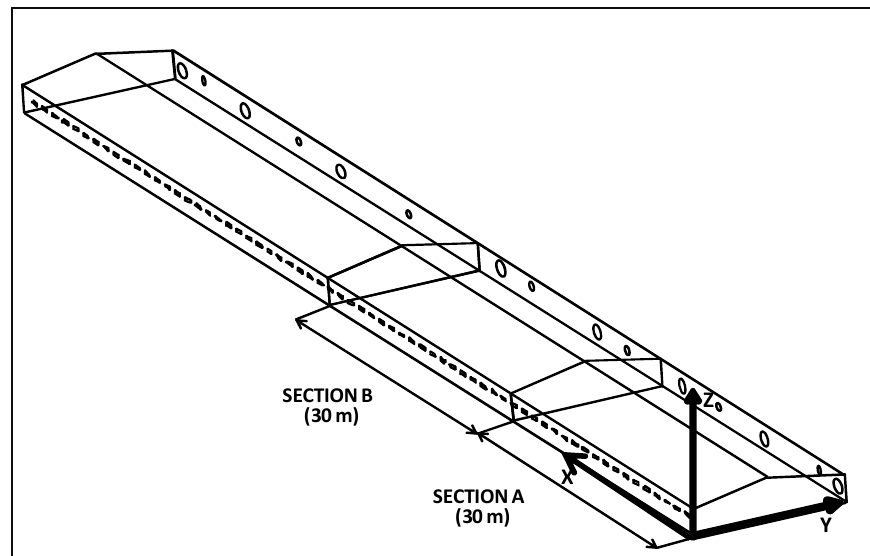
Figure 1. Test sections in the experimental poultry